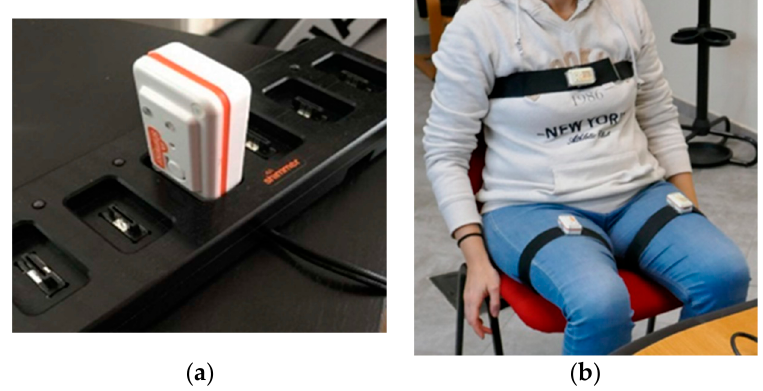
Figure 2. The lower limbs subsystem. ( a ) An inertial measurement unit (IMU) wireless sensor in the battery charger and ( b ) the designed configuration, with one sensor per thigh and one on the chest.